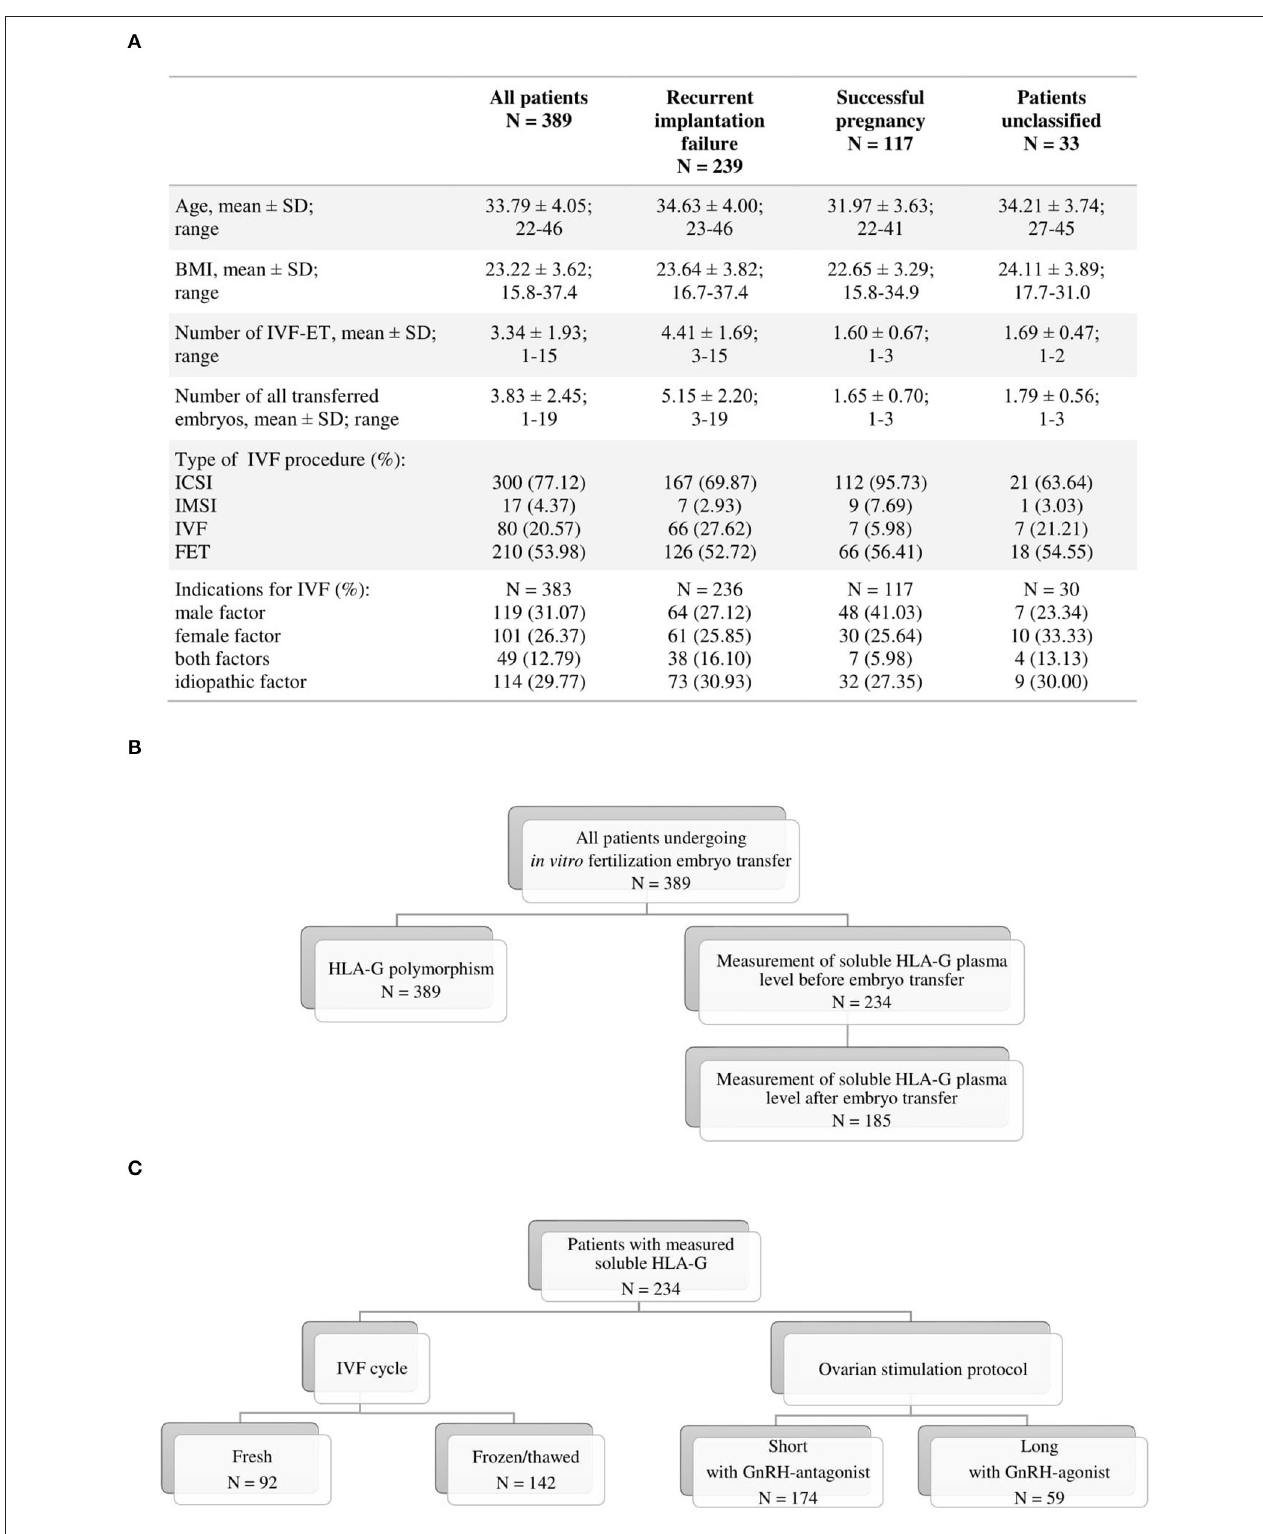
FIGURE 1 | Flowchart of study population. (A) Characteristics of patients; (B) strategy of study; (C) division of patients by type of IVF cycle and ovarian stimulation protocol. BMI, body mass index (kg/m 2 ); IVF-ET, in vitro fertilization–embryo transfer; ICSI, intracytoplasmic sperm injection; IMSI, intracytoplasmic morphologically selected sperm injection; FET, frozen/thawed embryo transfer; GnRH, gonadotropin-releasing hormone.